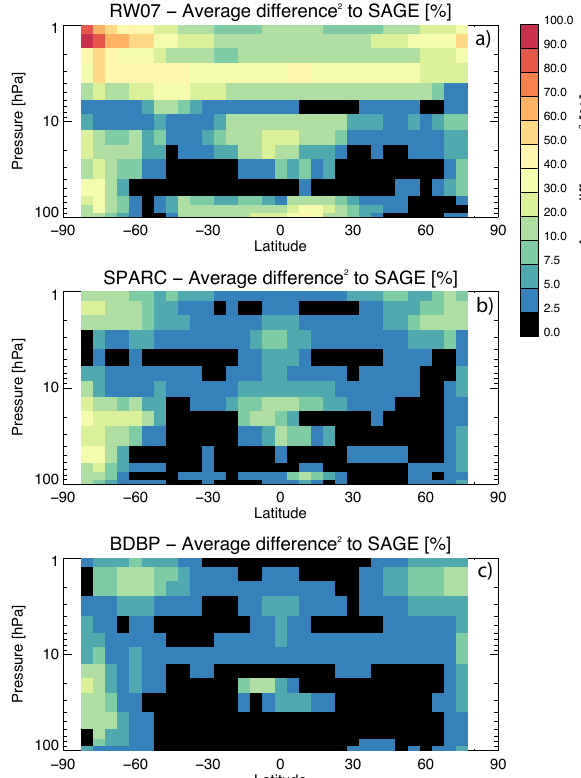
Fig. 10. Average squared difference between all available monthly mean SAGE II values for given latitude bands and pressure levels, and (a) the RW07 data set, (b) the SPARC data set, and (c) the BDBP data set, given in percent. Note that for RW07 at 100hPa some monthly means are not available between 20 ◦ S and 25 ◦ N due to missing tropospheric data. Colours changing from black to red indicate a change in average squared differences from 0% to 100%.